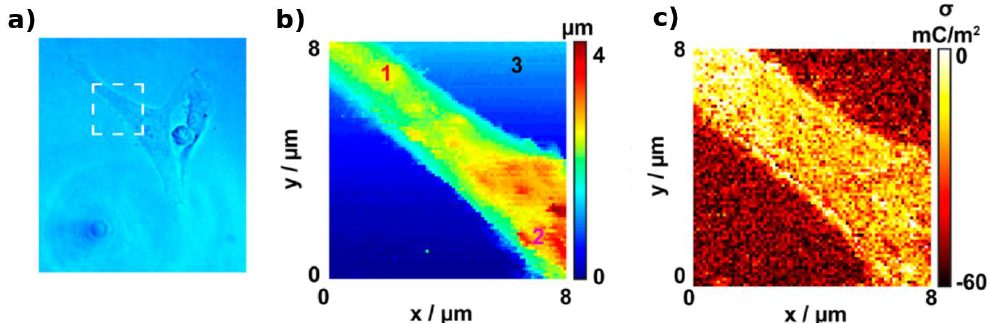
Figure 3. Imaging of a cell with ( a ) optical microscopy; ( b ) topographical data from scanning ion conductance microscopy (SICM) measurements and ( c ) surface charge data from SICM measurements. Adapted with permission from [116] Copyright 2016 American Chemical Society.